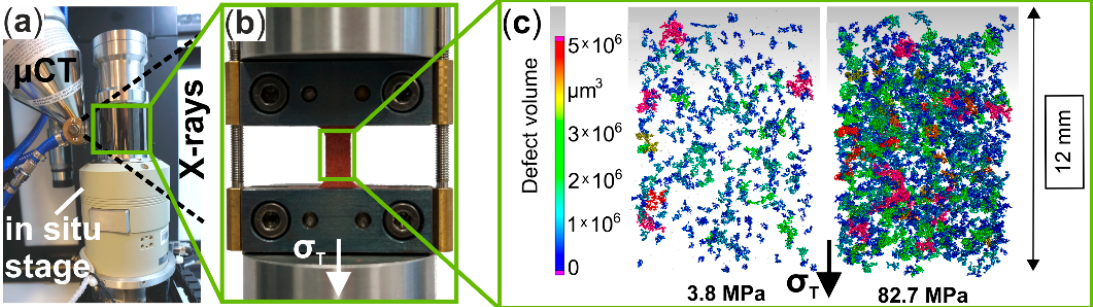
Figure 3. In situ tensile test in µCT: ( a ) integrated micro-tension/compression module (CT5000 GCT- RT, Deben Dortmund, Suffolk, UK); ( b ) the mounted µCT specimen; and ( c ) void volume in the specimen’s gauge length at two exemplary tensile stresses.